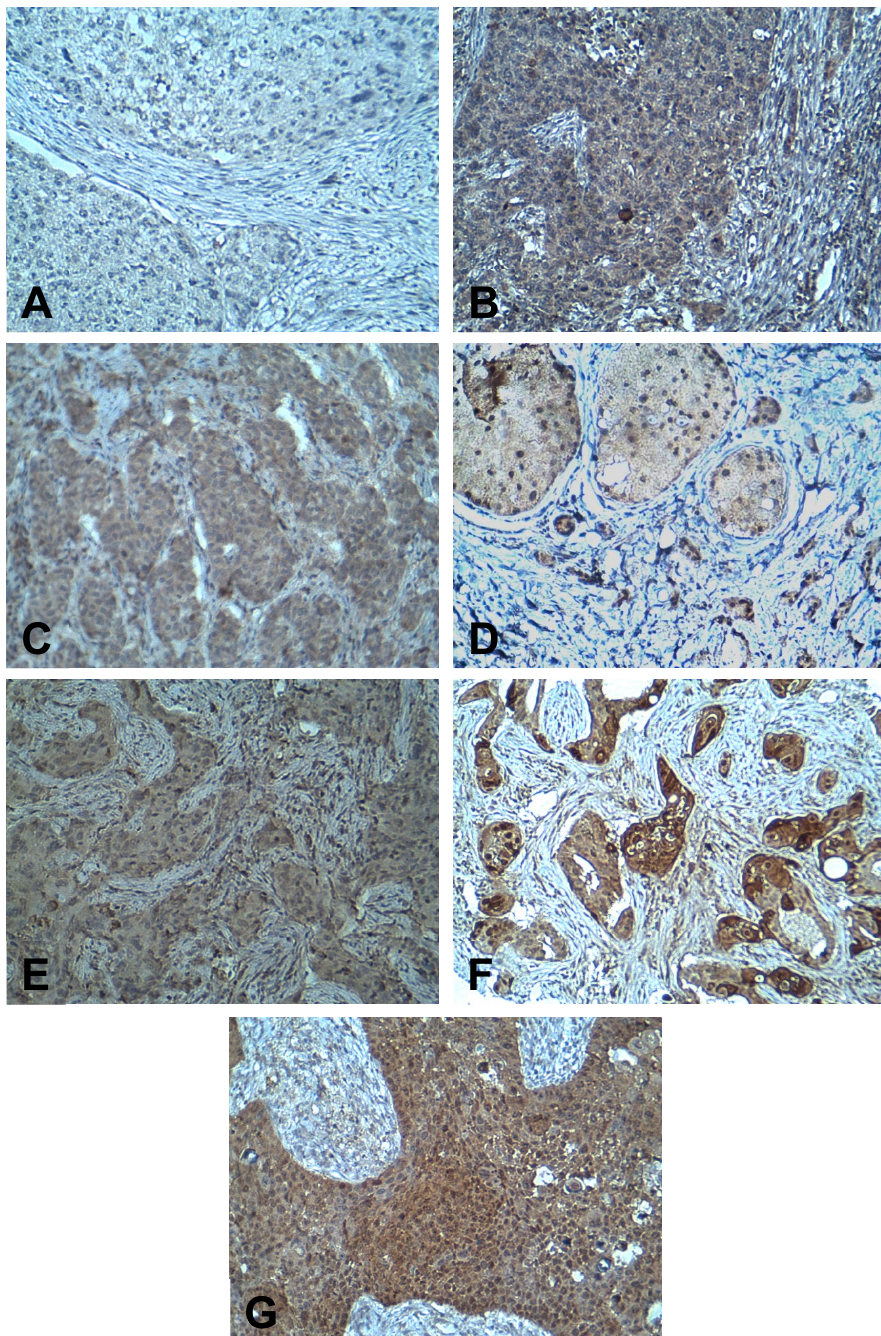
Figure 1. Immunohistochemistry staining for IR and c-MET in breast cancer. ( A ) Negative staining for IR; ( B ) mild staining for IR; ( C ) moderate staining for IR; ( D ) strongly positive staining for IR; ( E ) mild staining for c-MET; ( F ) moderate staining for c-MET; and ( G ) strongly positive staining for c-MET. [Magnification at x200]. IR, insulin